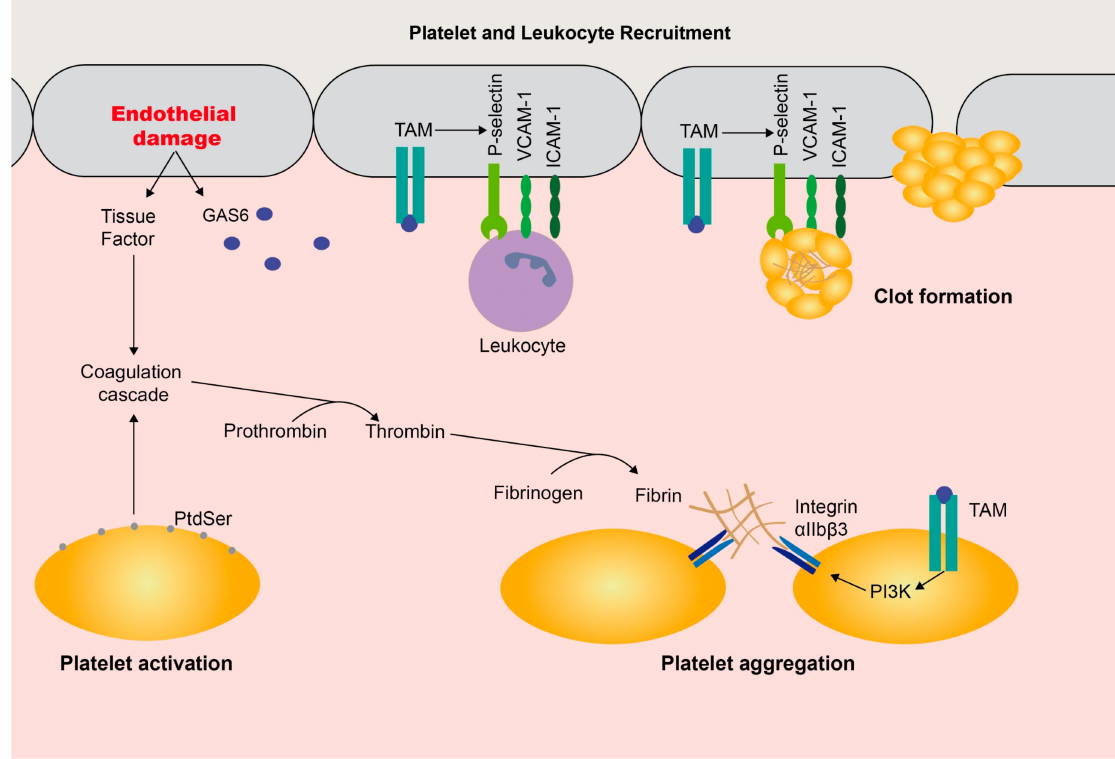
Figure 1. GAS6 / TAMs in hemostasis. During damage, growth-arrest-specific 6 (GAS6) is secreted by endothelial cells and its signaling upregulates the expression of adhesion molecules (P-selectin, VCAM-1 and ICAM-1) in the endothelium (grey). Thus, platelets (yellow) and leukocytes (purple), such as neutrophils, are recruited to damaged tissue allowing their interaction with the vessel intima. Besides, activation of platelets leads to phosphatidylserine (PtdSer) exposure and interaction with vitamin K-dependent proteins (VKDPs), including TAM ligands. Pro-coagulant Gla-proteins trigger coagulation cascade activation, while TAM activation promotes platelet aggregation and stabilization of clots by phosphoinositide 3-kinase (PI3K)-dependent phosphorylation of β 3 integrin increasing a ffi nity to fibrinogen and other